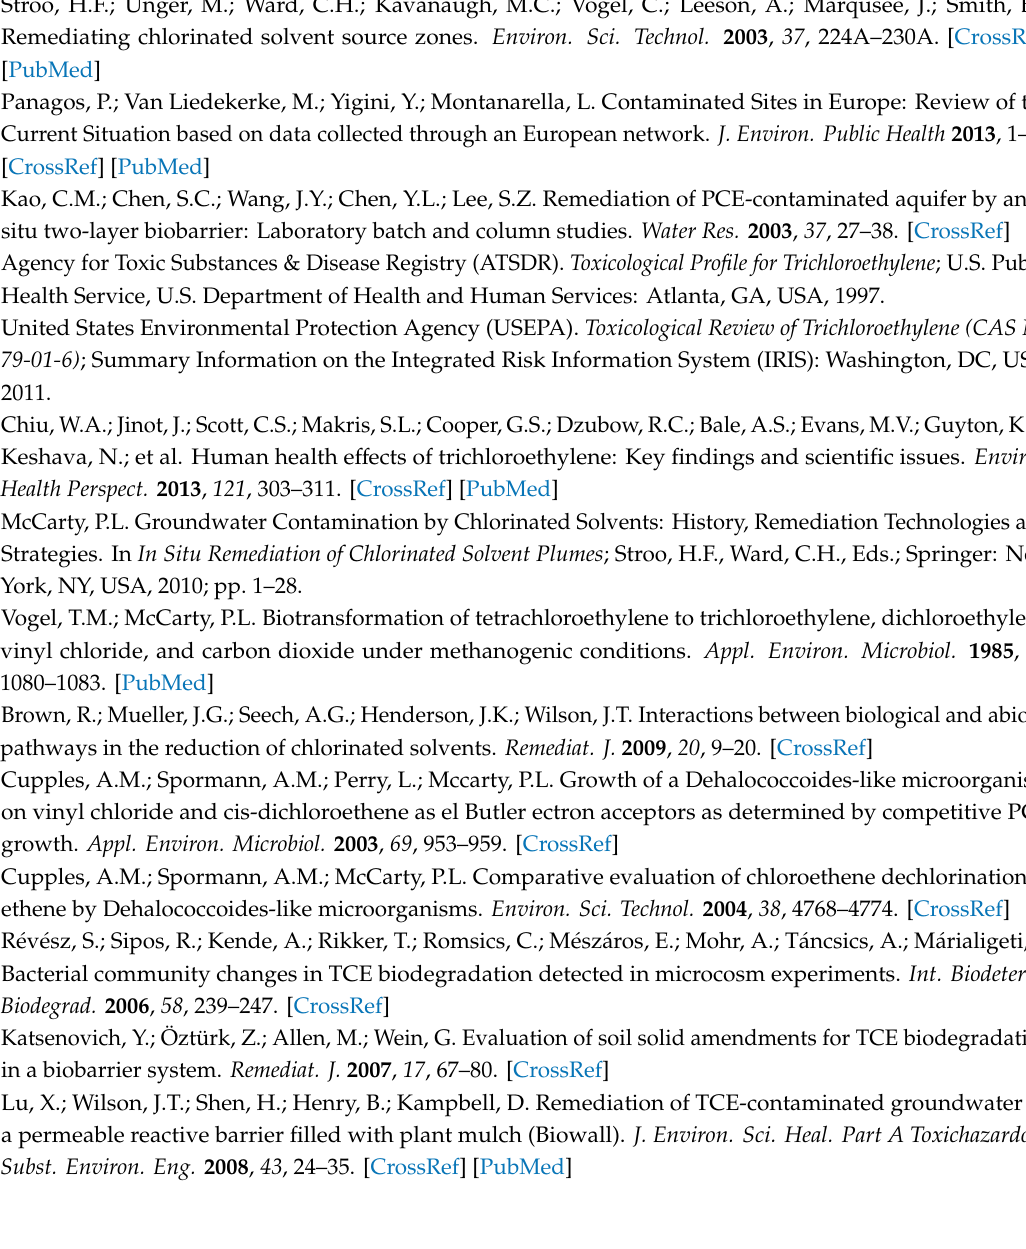
Figure S1: Reactive materials tested, Figure S2: TCE removal e ffi ciency for each reactive material during batch test, Table S1: Hydraulic conductivities for the individual materials and the